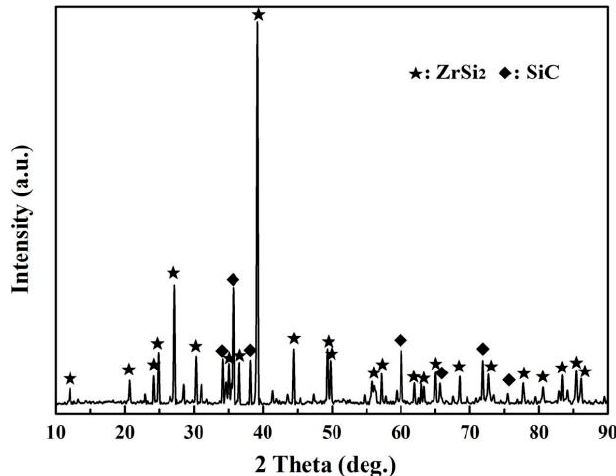
Figure 1. The XRD pattern of 20 wt.% ZrSi 2 -80 wt.% SiC mixed powders.